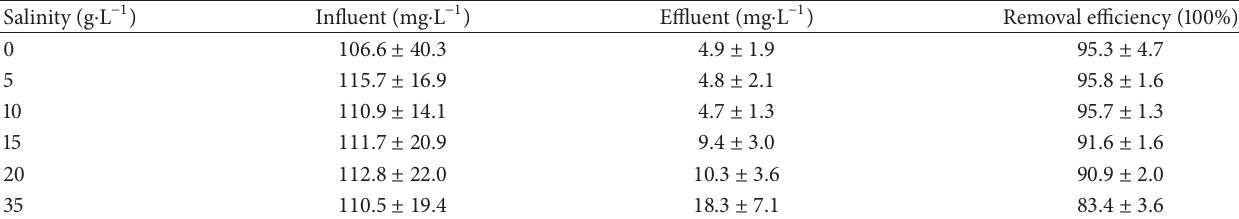
Table 2: Variations and removal efficiencies of TOC in five IAMBRs of different salinity during steady operations. Salinity (g ⋅ L −1